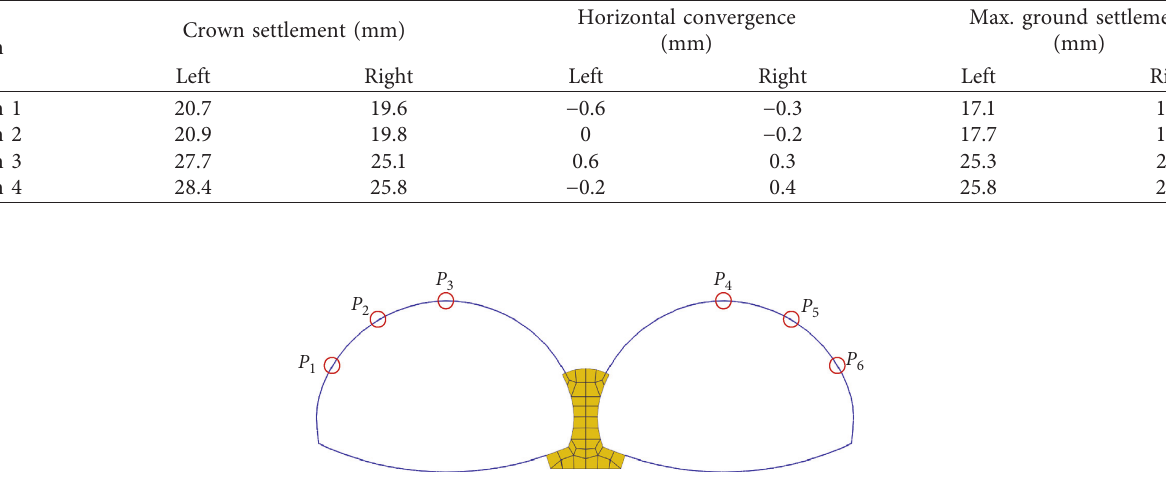
Table 4: Deformation of the surrounding rock under different stress release rates.